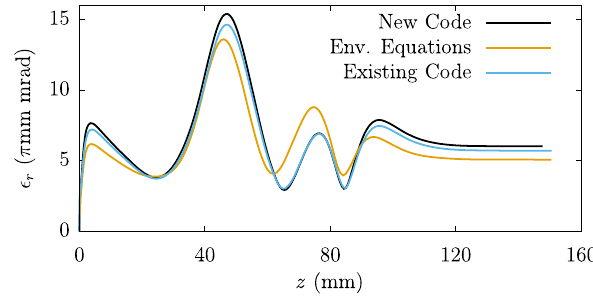
FIG. 8. Emittance evolutions for a charge of 1.0 nC per bunch in the BNL-type rf cavity. The rf gun cavity structure is located from z ¼ 0 to 77.67 mm.